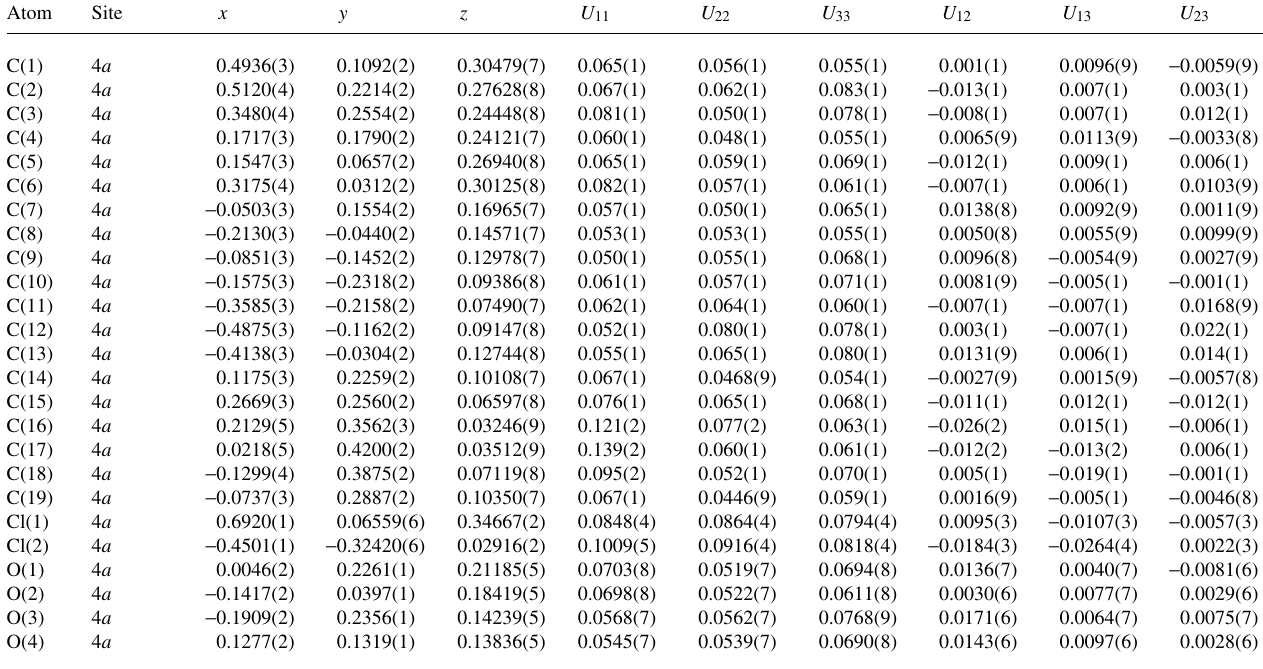
Table 3. Atomic coordinates and displacement parameters (in Å 2 )